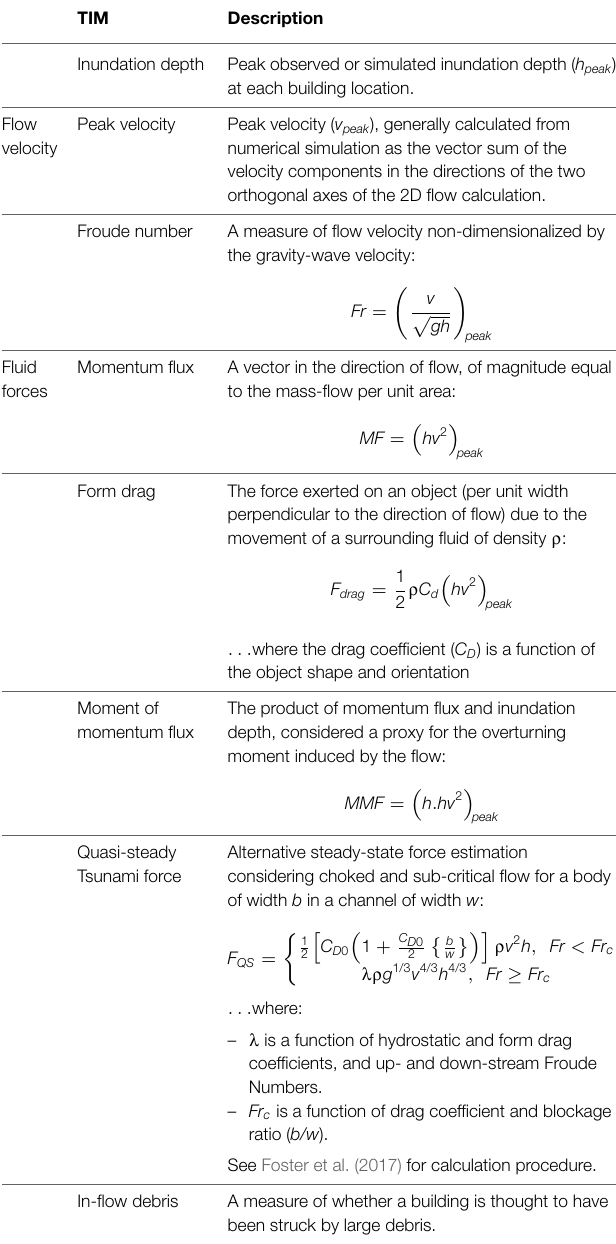
TABLE 7 | Tsunami Intensity Measures (TIMs) used in the current literature. TIM